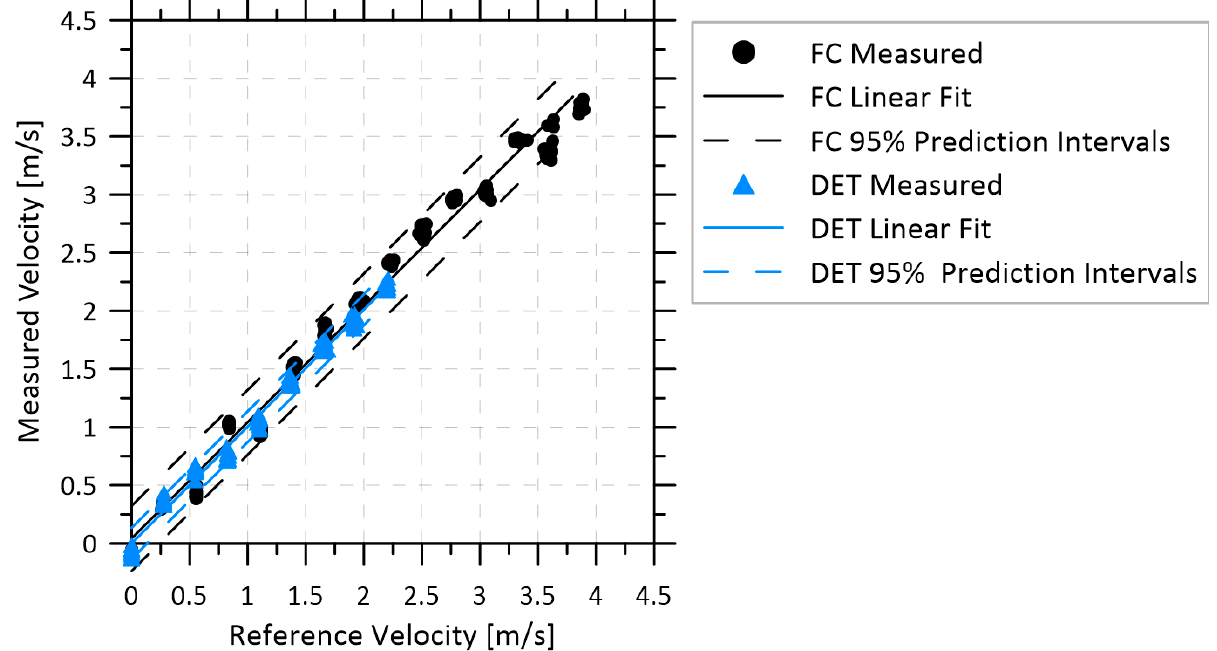
Figure 5. Velocity data from Figure 4 for both configurations, plotted as measured velocity from the sensor versus reference velocity from the mass flow controllers. Linear regressions of these data and prediction intervals at 95% confidence are shown for both configurations. Figure 6 compiles six independent datasets for each of the FC and DET configura- tions (dots and crosses, respectively) to show the absolute error in measured